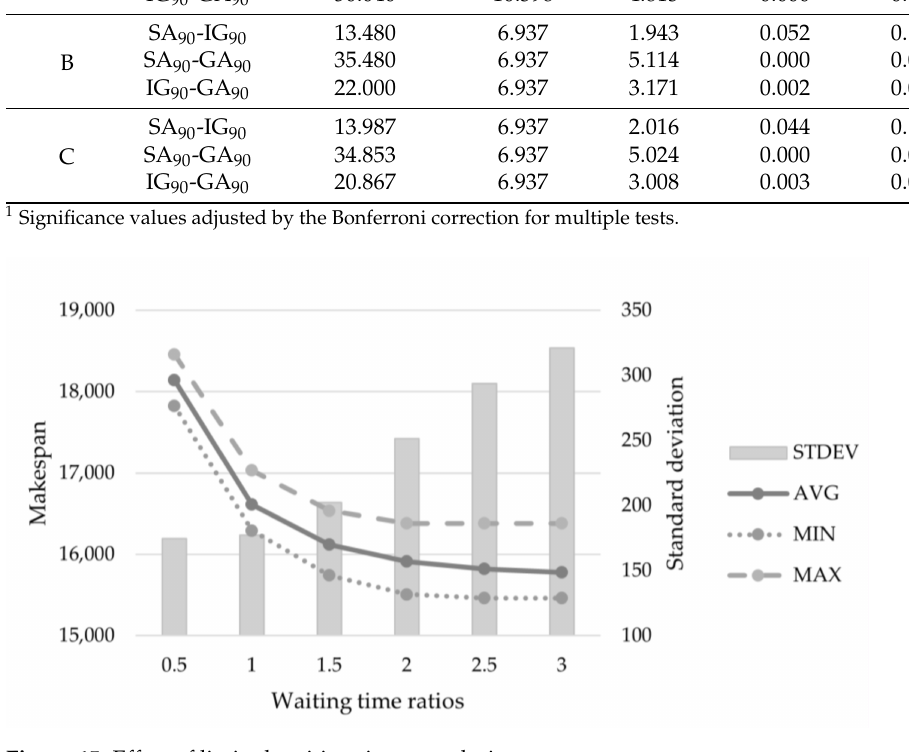
Figure 15. Effect of limited waiting time on